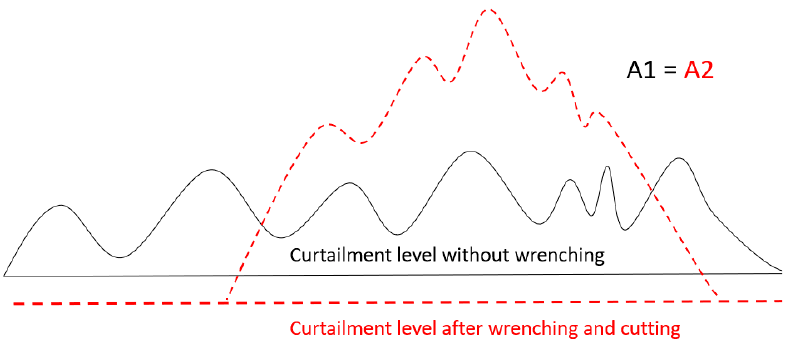
Figure 9. Illustration of the “wrench and cut” principle.